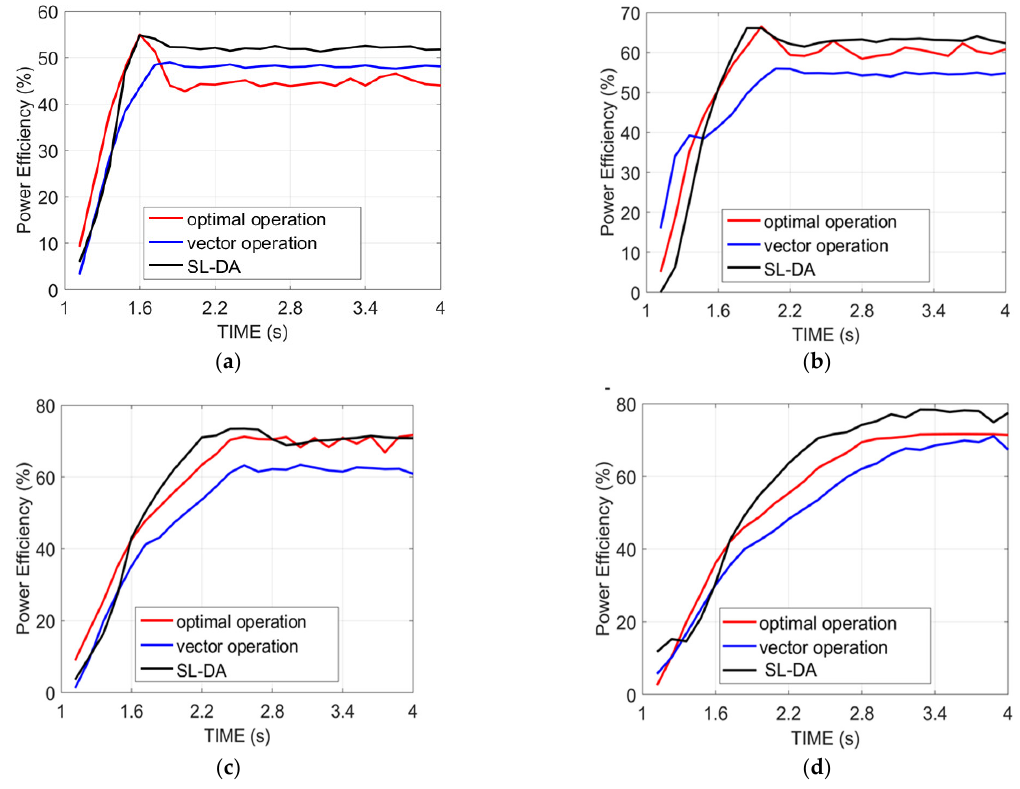
Figure 8. Analysis on the power efficiency of proposed work over conventional models: ( a ) speed 90 and torque 130; ( b ) speed 120 and torque 150; ( c ) speed 150 and torque 180; and ( d ) speed 180 and torque 200.